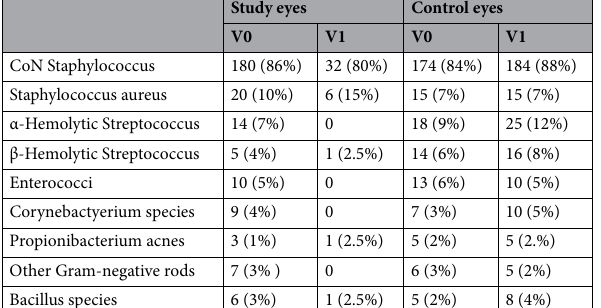
Table 3. Isolated bacteria in the study population. V0 baseline visit, V1 visit the day of intravitreal injection, CoN